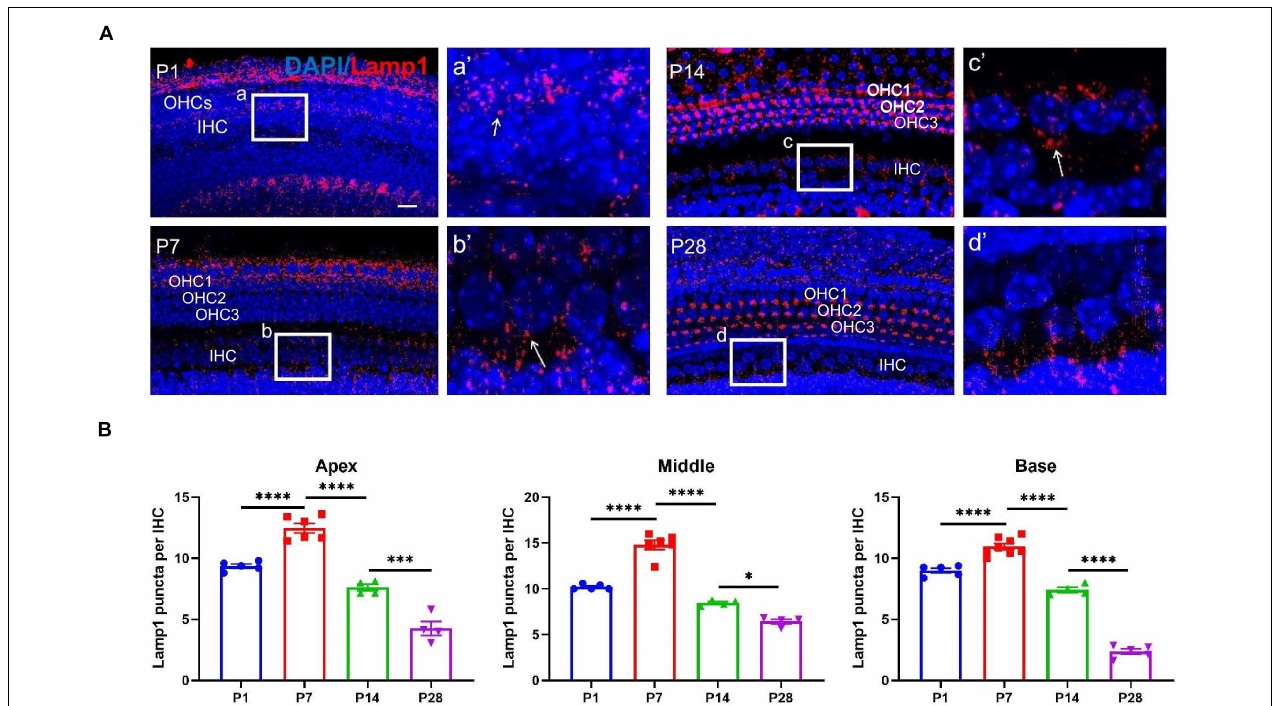
FIGURE 5 | LAMP1 detection in the ribbon synapses regions. (A) LAMP1 was identified using anti-LAMP1 (red, indicated), and white frames at P1 (a) , P7 (b) , P14 (c), and P28 (d) indicate the regions of ribbon synapses; (a (cid:48) –d (cid:48) ) are enlarged images of panels (a–d) , respectively; white arrows indicate LAMP1-stained positive spots. Scale bar = 5 µ m. (B) Quantitative analysis of the number of positive puncta on P1, P7, P14, and P28. Correspondingly, the highest number of LAMP1 puncta appeared at P7, and a remarkable loss of LAMP1 puncta was found at P14 and P28 across frequencies (apex, middle and base) (* p < 0.05; *** p < 0.001; **** p < 0.0001). LAMP1, lysosomal-associated membrane